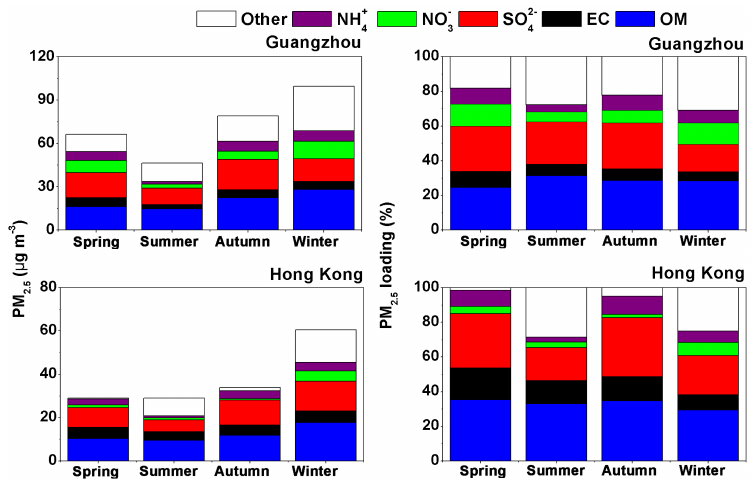
Figure 6. Seasonal PM 2 . 5 and dominant chemical components in